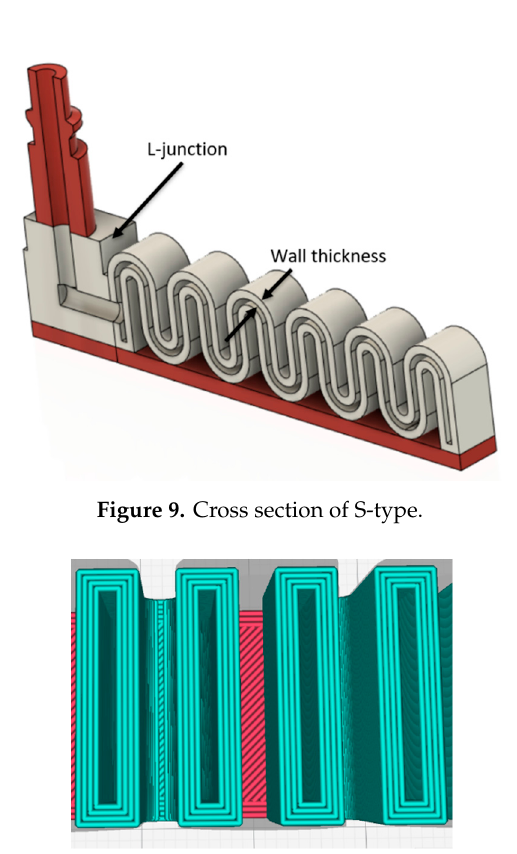
Figure 10. Top view of the S-type into the slicing software, it is possible to see the four adjacent lines of extruded materials; each one has width of 0.4 mm, which compose the 1.6 mm thickness of the chamber walls.